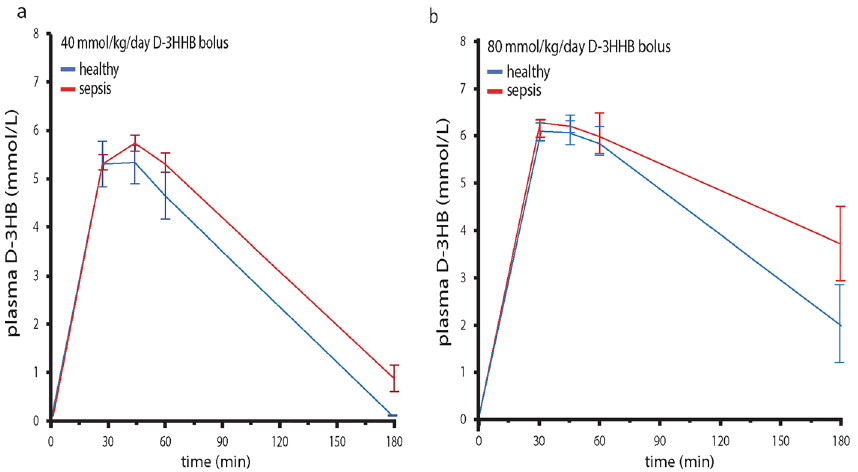
Figure 5. Impact of sepsis on estimated d-3HB clearance after bolus injection of d-3HHB. Repeated blood samples were collected and d-3HB was quantified at 30, 45, 60 and 180 min after bolus injection of pure d-3HHB at ( a ) 40 mmol/kg/day or ( b ) 80 mmol/kg/day. Healthy mice are indicated with blue lines, septic mice are indicated with red lines. N =